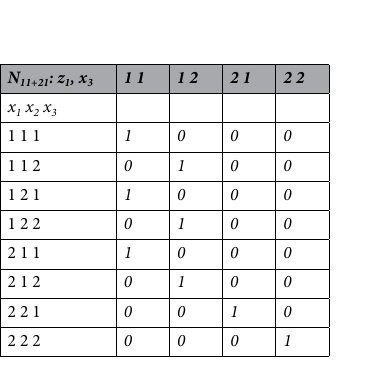
Table 2. Boolean matrix of node N 11 + 21 .